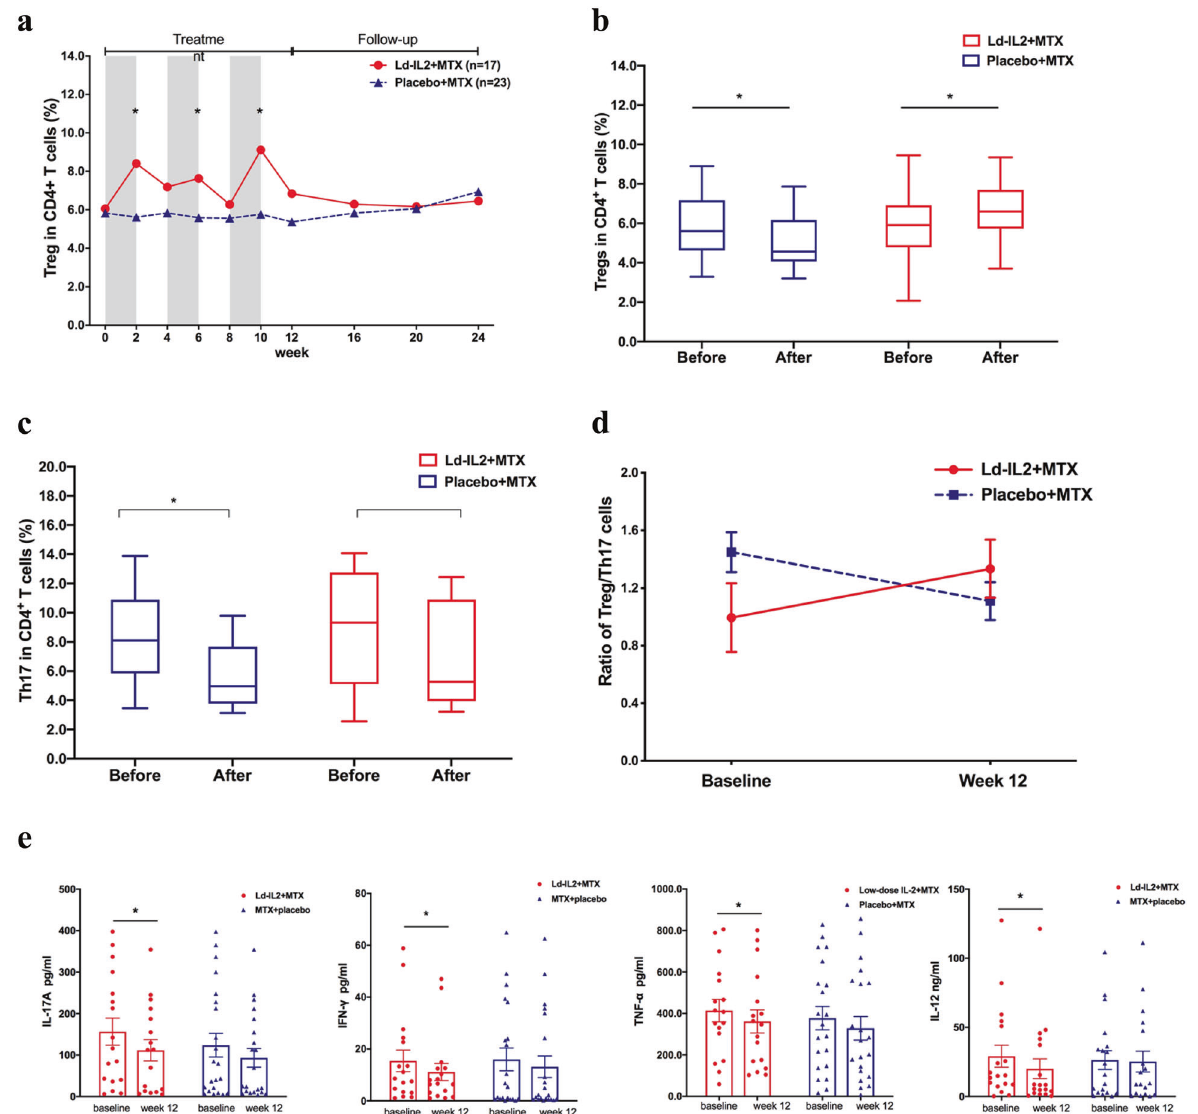
Fig. 4 Ld-IL2 therapy synergized with MTX to expand the population of Tregs and ameliorate in fl ammation of RA. The proportion of Tregs in CD4 + T cells. Grey areas indicated the periods on Ld-IL2 or placebo therapy ( a ). The changes of the proportion of Tregs or Th17 in Ld-IL2 combined with MTX group and MTX alone group ( b, c ). The ratio of Tregs/Th17 ( d ). The serum levels of IL-17A, IFN- γ , TNF- α , and IL-12 were decreased signi fi cantly at week 12 ( e ). Data in bar graphs were mean ± SE. Ld-IL2 low-dose interleukin-2, MTX methotrexate, Treg regulatory T cell. * P <